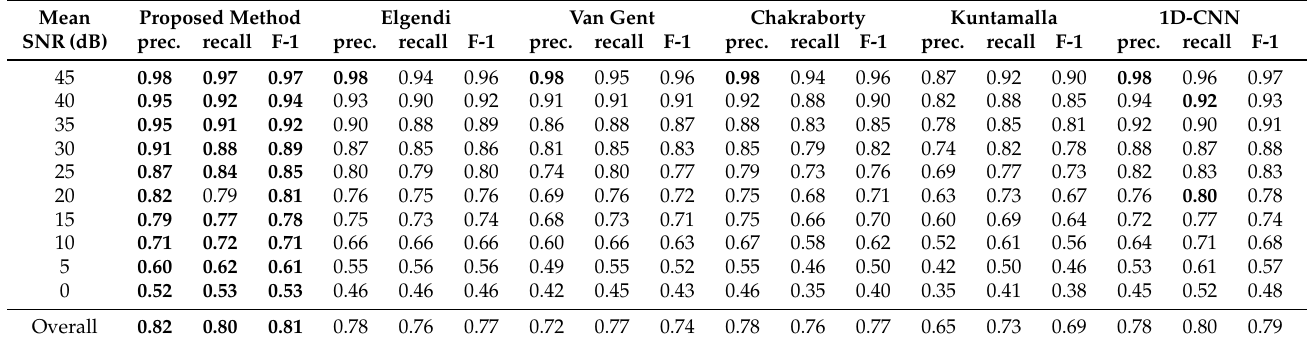
Table 2. Performance comparison between the proposed method and the other existing methods.